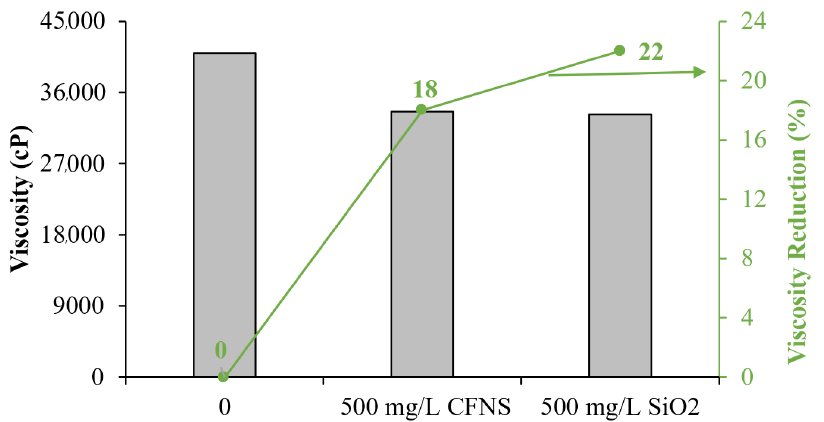
Figure 7. Degree of viscosity reduction for EHO in the presence of CFNS and SiO 2 at 25 °C and 500 mg/L.